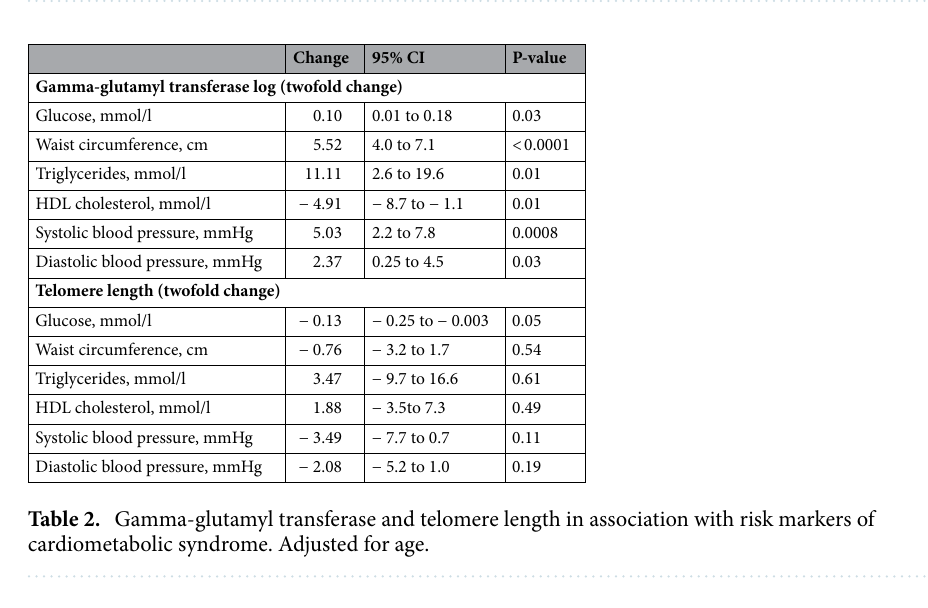
Figure 2. Gamma-glutamyl transferase in association with relative adult telomere length in buccal cells. The main model is adjusted for sex, age (linear and quadratic), zygosity and chorionicity, education twin, maternal education, waist-to-hip ratio, and smoking (n = 200). The second model is additionally adjusted for telomere length at birth (n = 137). The third model is additionally adjusted for medication use, possibly associated with gamma-glutamyl transferase, during the last 14 days prior to the examination (n = 200). The figure was plotted using GraphPad Prism version 5.00 (https:// www. graph pad. com/).